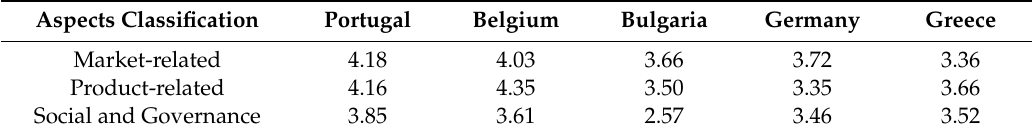
Table 6. Belgium, Bulgaria, Germany, Greece, and Portugal categories average evaluation. Aspects